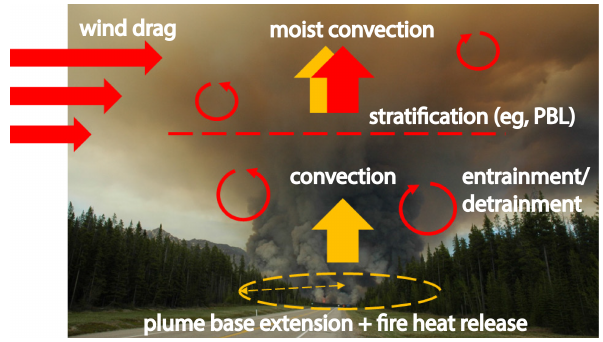
Figure 2. Schematic view of the physical processes involved in fire plume dynamics. Red and yellow colours stand for atmospheric or fire-induced mechanisms